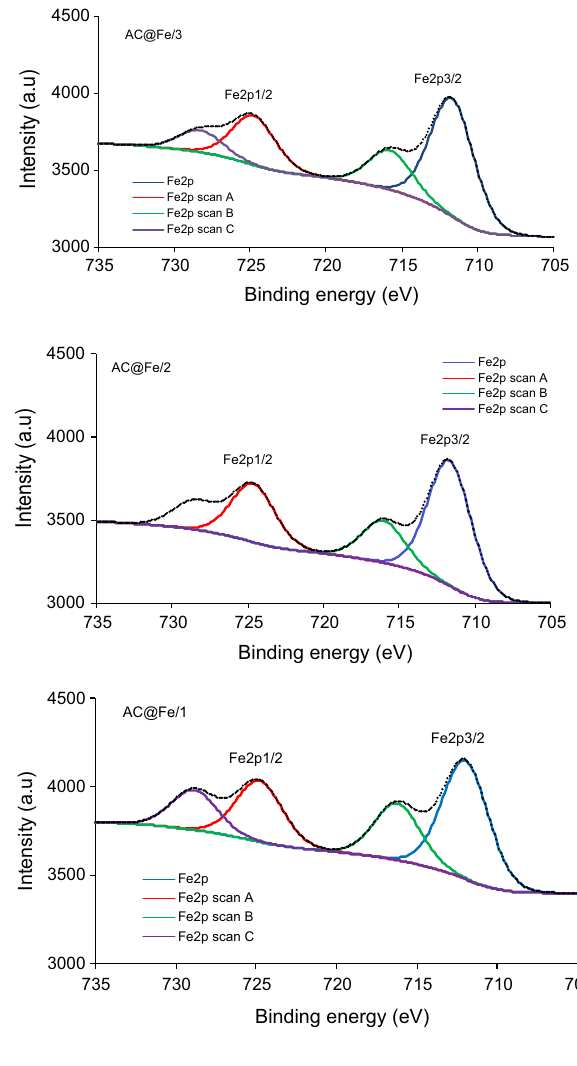
Fig. 1 Fe2p XPS spectra of AC@Fe/1, AC@Fe/2 and AC@Fe/3 cat-